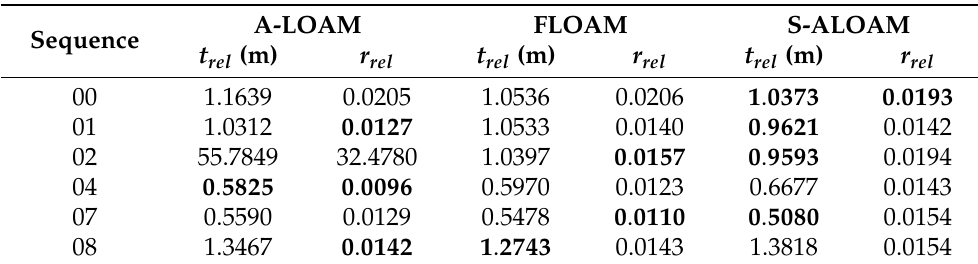
Figure 10. The real image in Sequence 08. Table 3. The relative errors per 100 m, where t rel represents root-mean-square error (RMSE) of translations, while r rel represents rotation error. Because LeGO-LOAM suffers large errors, the corresponding errors are not given here. Bold indicates the best result. Note that rotation error has no